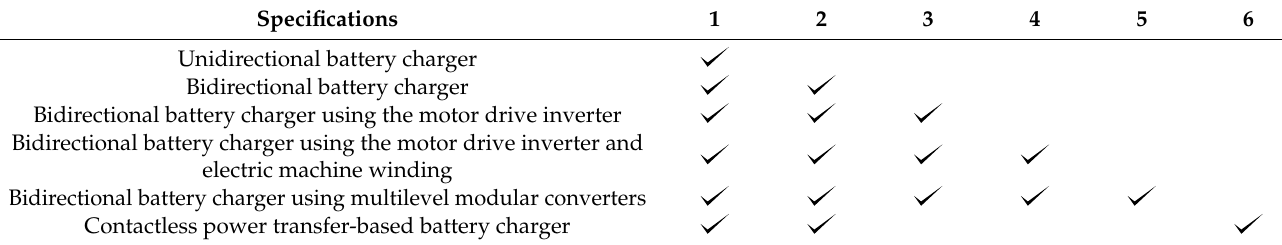
Table 5. Specifications and proposed power electronics topologies (Numbers 1 to 6 refer to